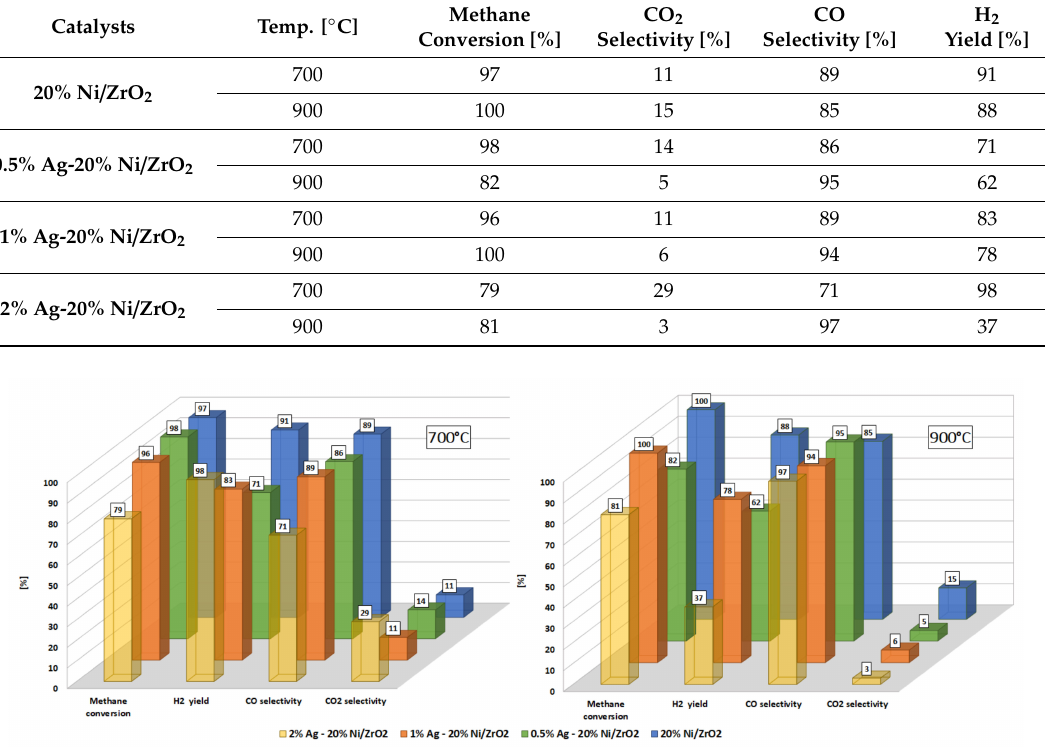
Figure 2. The activity results of the investigated Ni and Ag-Ni catalysts in oxy-steam reforming (OSR) of methane